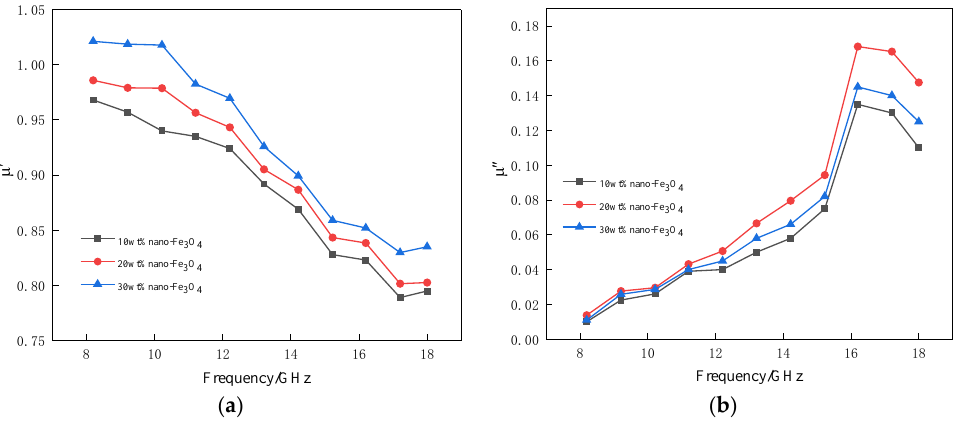
Figure 6. Complex permeability of nano-Fe 3 O 4 /PLA composite absorbers with different nano-Fe 3 O 4 content. ( a ) The real part of the complex permeability; ( b ) the imaginary part of complex permeability.